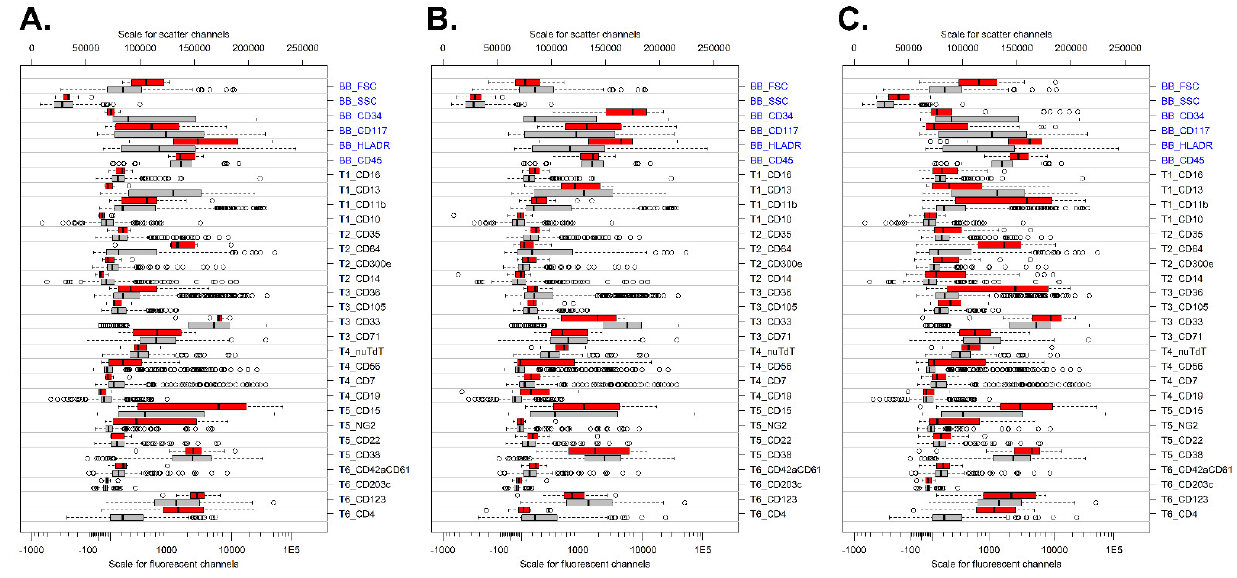
Figure 4. Immunophenotypic profile of specific WHO categories. ( A ) Comparison of t(9;11) cases (red; n = 9) versus all other AML cases (gray; n = 392). ( B ) Patients with t(8;21)-positive AML (red; n = 16) versus all other AML cases (gray; n = 385). ( C ) Patients with monoblastic/monocytic AML (red; n = 30) versus all other AML cases (gray; n = 371). For each marker, the median fluorescent intensity is shown. The boxes themselves represent the interquartile range (first up to third quartile), and the vertical bars within the boxes represent the median. Data were sorted from top to bottom based on the delta median for the red group (selected cases) and the gray group (all other AML cases). Backbone (BB) markers are shown in blue, and T1-T6 refer to markers present in tube 1 to tube 6.